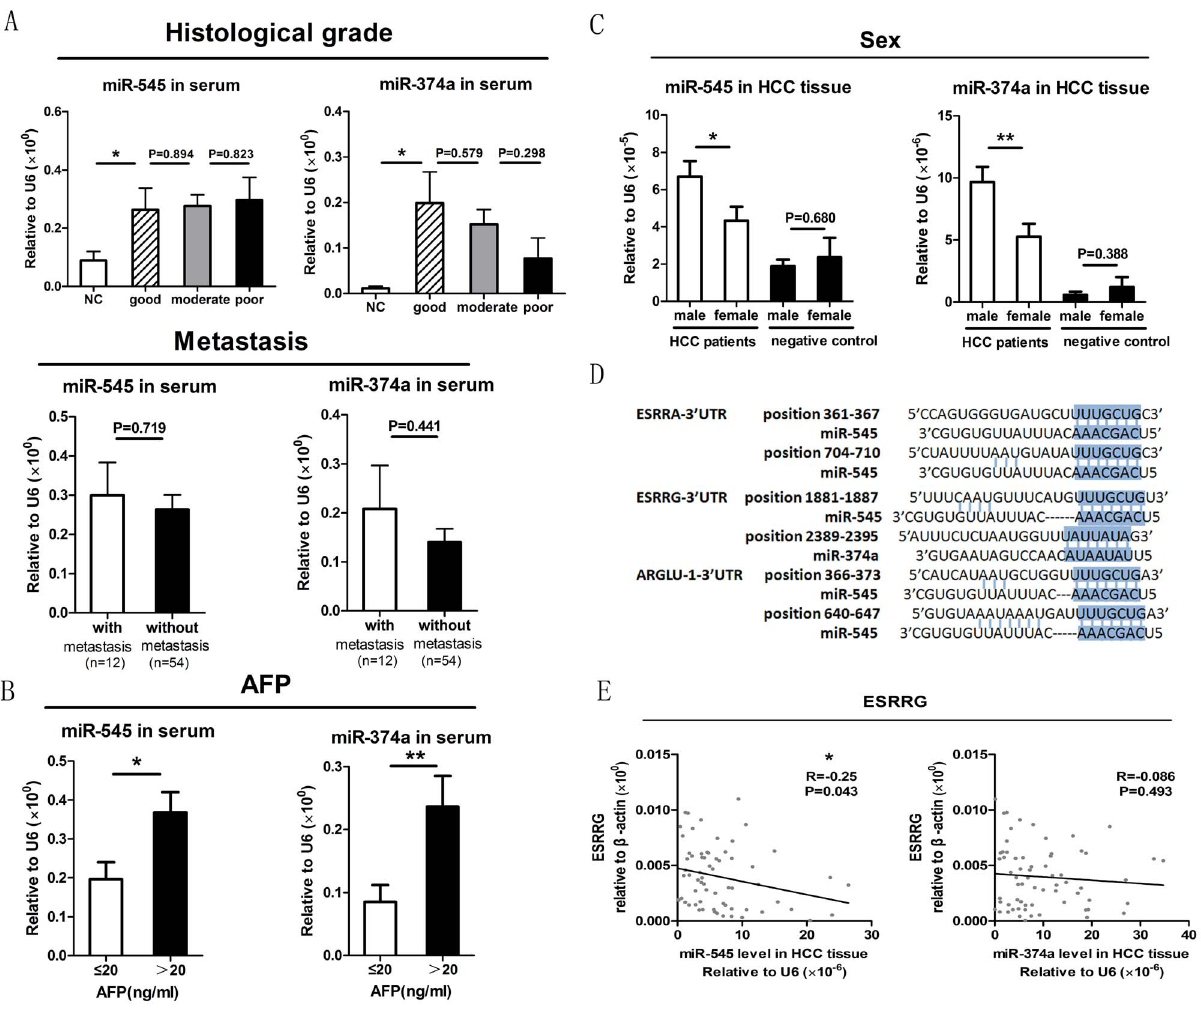
Figure 5. Correlation analysis of preoperative miR-545/374a serum expression with prognosis/diagnosis-related clinical features. (A) Correlation analysis of preoperative miR-545/374a serum levels with the prognosis-related clinical features of histological grade and metastasis. The histological grade was classified by pathological analysis as good, moderate or poor. Sera levels of miR-545/374a were analyzed by quantitative RT-PCR. The error bars in A represent mean 6 Std. deviation. (B) Correlation analysis of preoperative miR-545/374a serum levels with the diagnosis- related clinical feature of AFP. The correlation analysis of CEA and c -GT with the levels of miR-545/374a are shown in figure S1B. The error bars in B represent mean 6 Std. deviation. (C) Gender-based investigation of Ftx microRNA cluster expression. HCC subjects and negative control subjects were grouped according to gender. MicroRNA 545 and miR-374a expression in HCC tissue was assayed by quantitative RT-PCR and compared between these groups. The error bars in C represent mean 6 Std. deviation.*P , 0.05, **P , 0.01, t test. (D) Putative sex-related miR-545 and miR-374a target genes. The sequences comprising the miR-545 and miR-374a target sites are shown. (E) Correlation between HCC tissue miR-545/374a expression and ESRRG gene expression. The levels of miR-545/374a and ESRRG were monitored in 66 HCC tissue samples by quantitative RT-PCR. The correlation analysis of ESRRA and ARGLU-1 with miR-545/374a are shown in figure S1C. *P , 0.05, Pearson’s correlation test.